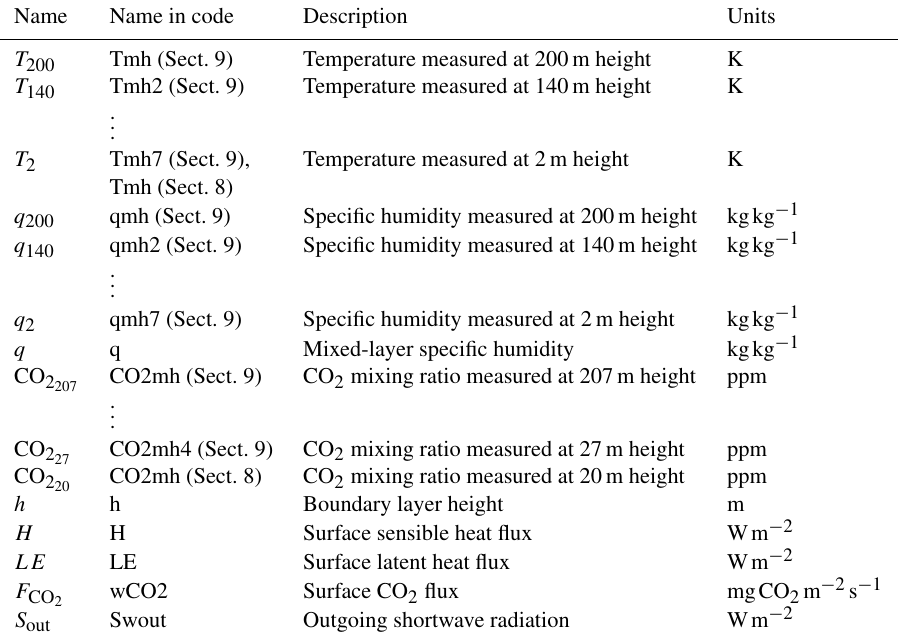
Table A2. Used observation streams in this paper. Note that variables such as T 200 and T 140 are called Tmh and Tmh2, respectively, in the model code for Sect. 9, which represents temperatures at the user-specified temperature measuring heights 1 and 2, respectively. For the CO 2 mixing ratio, we do not make a distinction in this paper between the moist-air and dry-air mixing